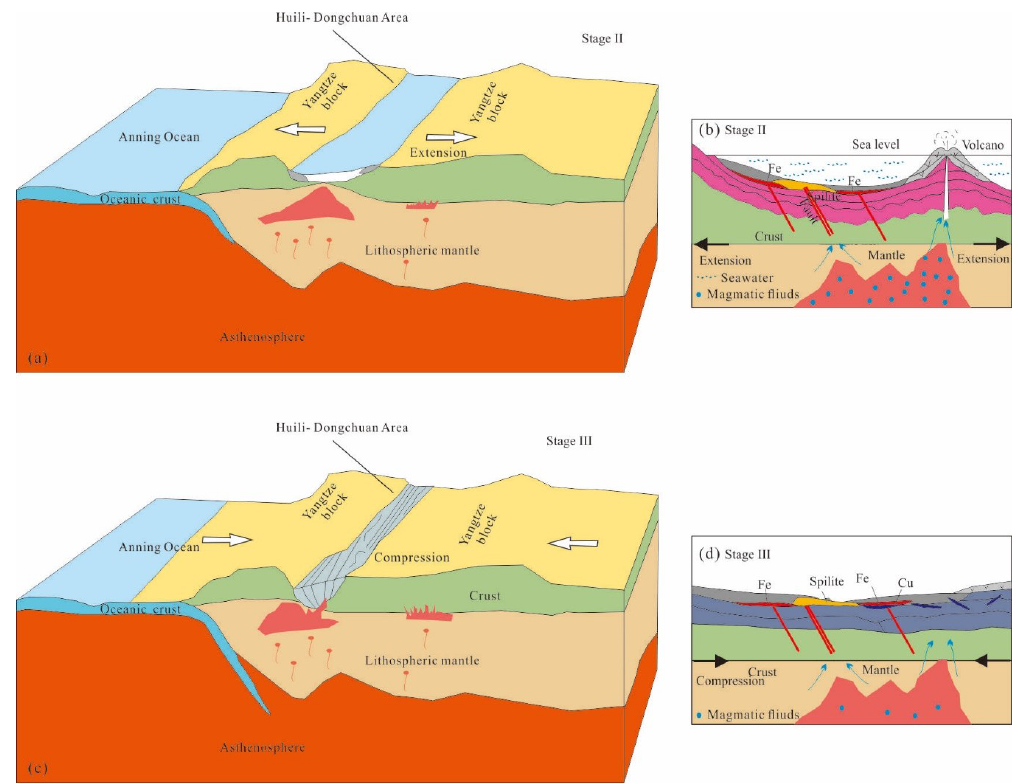
Figure 13 Figure 13. Schematic ore deposit model for the two-stage mineralization in the Xianglushan Fe-Cu orefield; ( a ) Tectonic setting of Huili-Dongchuan at Stage II, showing the formation of a backarc basin; ( b ) Stage II mineralization, showing the formation of Fe orebodies; ( c ) Tectonic setting of Huili-Dongchuan at Stage III, showing the backarc basin inversion; ( d ) Stage III mineralization, showing the formation of Cu